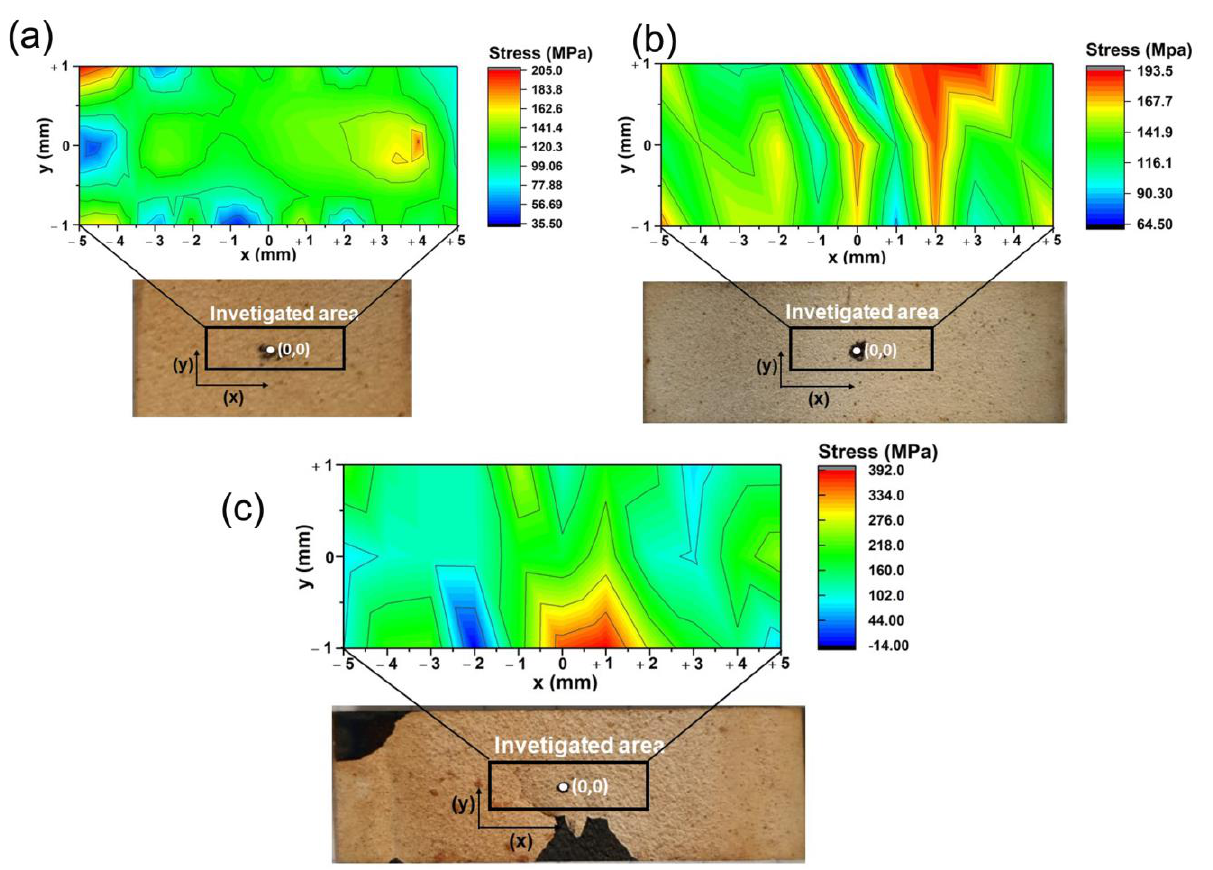
Figure 7. Residual stress map of the steel sample with ceramic coatings ( a ) residual stress map of the PS sample on the selected measurement area; ( b ) residual stress map of the 5 cycles sample on the selected measurement area and ( c ) 10 cycles sample on the selected measurement area.